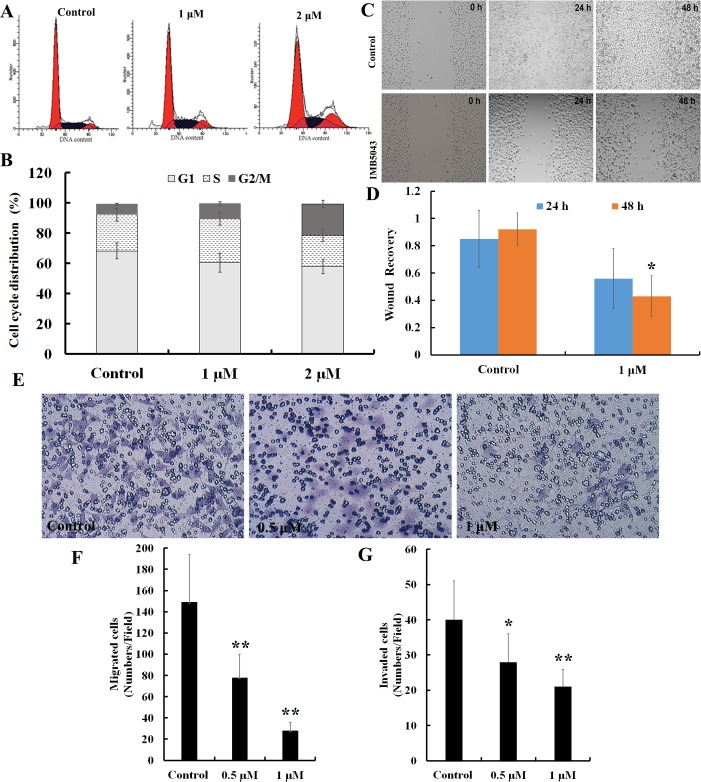
IMB5043 arrests G2/M phase and decreases the motility and invasion of SMMC-7721 cells.(A). Cell cycle distribution was determined by flow cytometry after PI staining. Representative pictures from three experiments are shown. (B). Quantification of cell population in different phases of cell cycle treated with IMB5043. SMMC-7721 cells were treated with indicated doses of IMB5043 for 24 hours. Data represents the mean ± SD of three independent experiments. (C) IMB5043 decreases the motility of SMMC-7721 cells by wound closure assay. Representative pictures from three experiments were taken under microscopy after the incision and treated with 24 h, 48 h of 1 μM IMB5043 (x100). (D) Quantification of healing capability of SMMC-7721 cells after treated with IMB5043. *P<0.05. (E) IMB5043 decreases the migration of SMMC-7721 cells by transwell assay. Representative pictures from three experiments were taken under microscopy. SMMC-7721 cells were treated with the indicated concentrations of IMB5043 for 16 h. Cells that migrated through the transwell membrane were stained with hematoxylin (200×). (F) Quantification of migrated cells treated with IMB5043 in SMMC-7721 cells. Data shown is means ± SD of the three independent experiments. **P<0.01. (G) Quantification of invaded cells treated with IMB5043 in SMMC-7721 cells. *P<0.05; **P<0.01. Data represents the means ± SD of the three independent experiments.